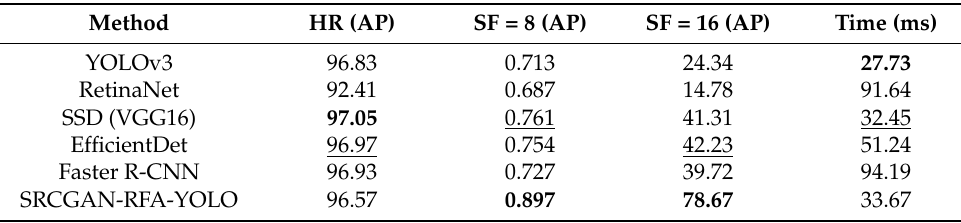
Table 6. The impact of scale factor on the detection AP with an IoU of 0.10.